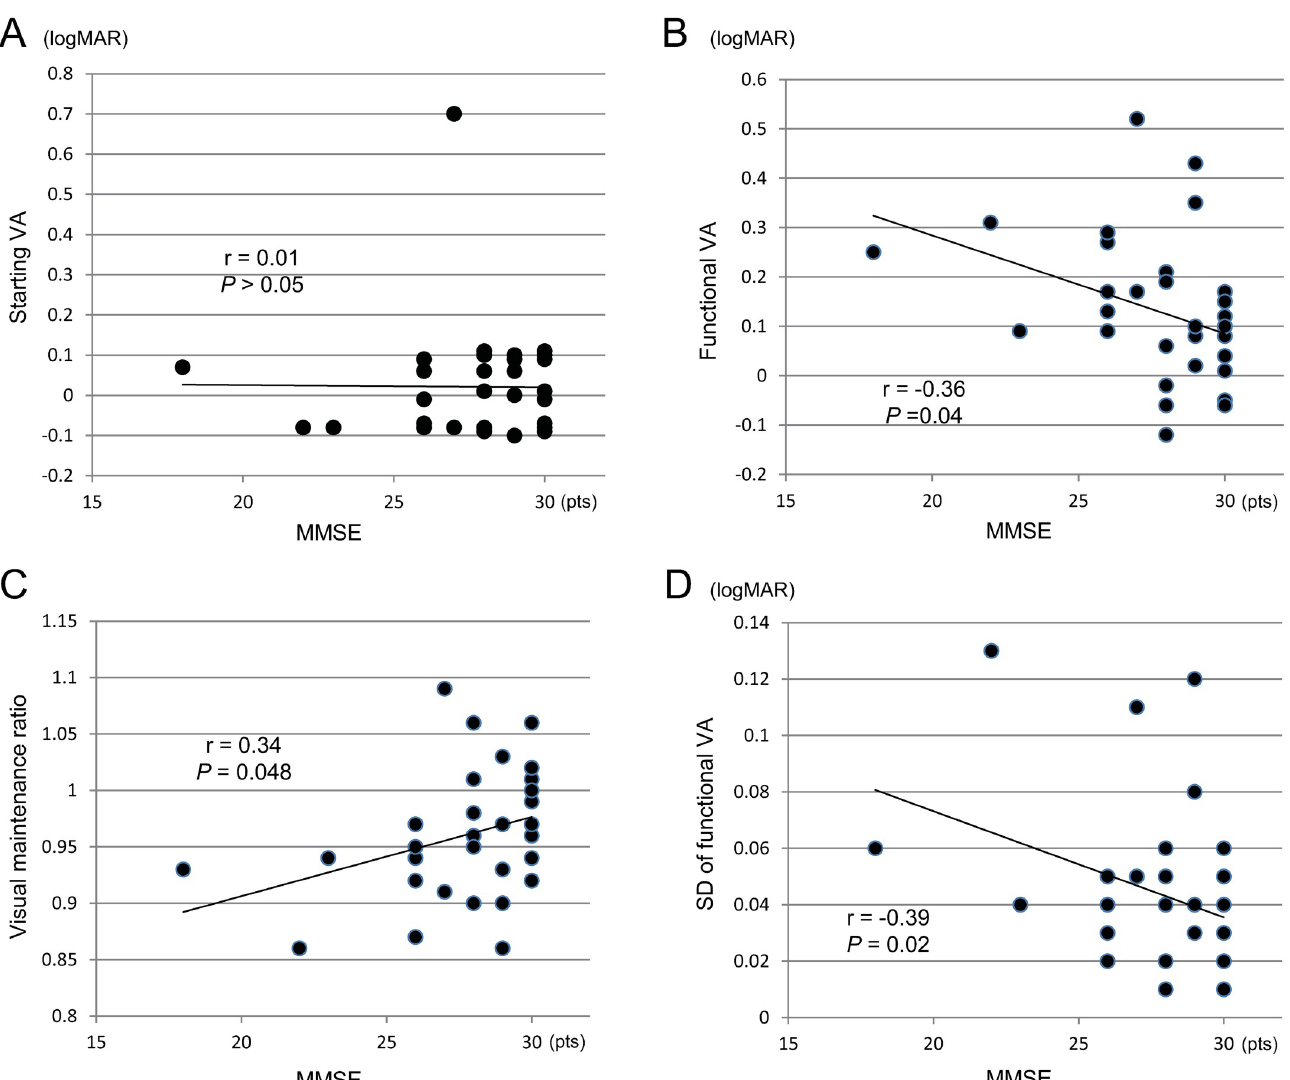
Fig 5. Correlation between cognitive function and visual function. (A) Correlation between the logMAR starting VA and the MMSE score. (B) Correlation between the logMAR functional VA and the MMSE score. (C) Correlation between the visual maintenance ratio and the MMSE score. (D) Correlation between the logMAR standard deviation of functional VA and the MMSE score. logMAR, logarithm of the minimum angle of resolution; MMSE, Mini-Mental State Examination; VA, visual acuity.